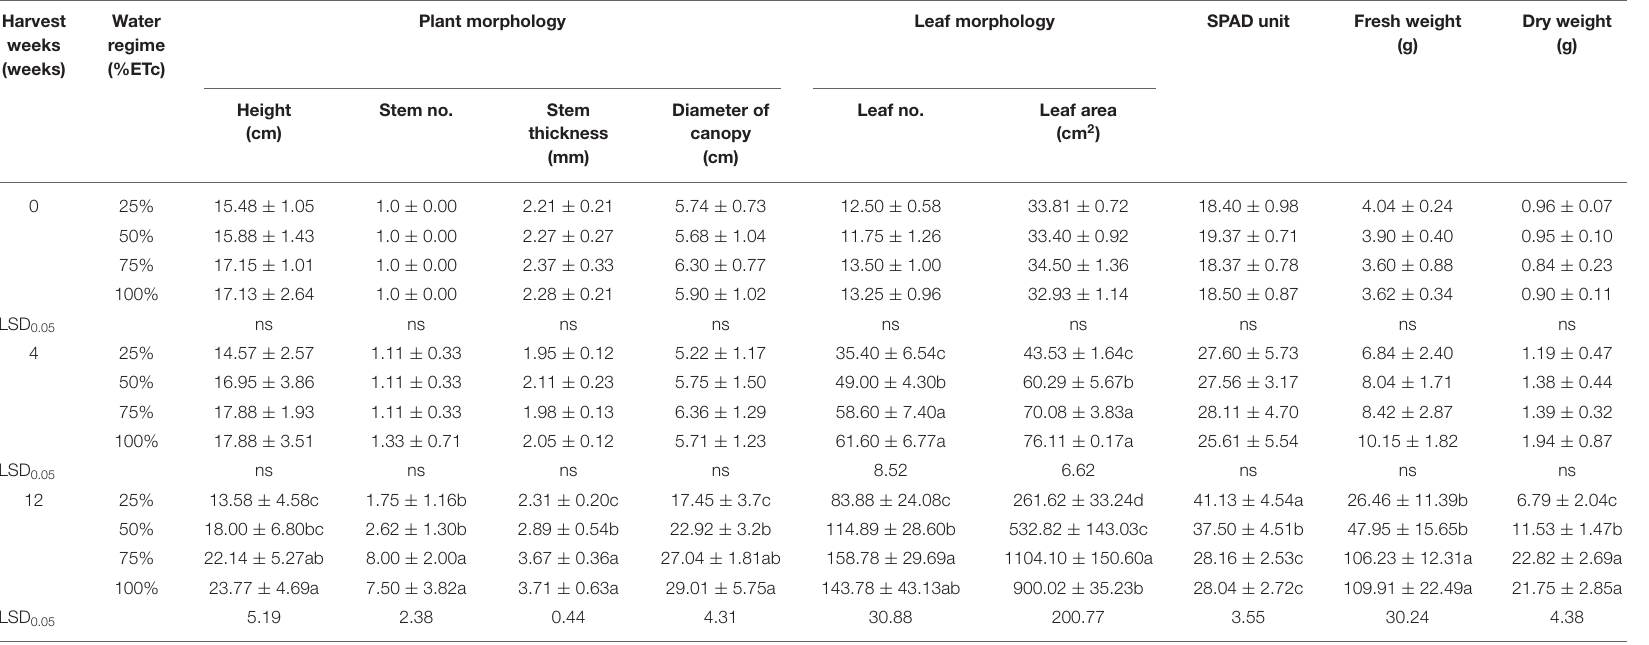
TABLE 1 | Physiological changes of potted Mentha arvensis grown in greenhouse with different water